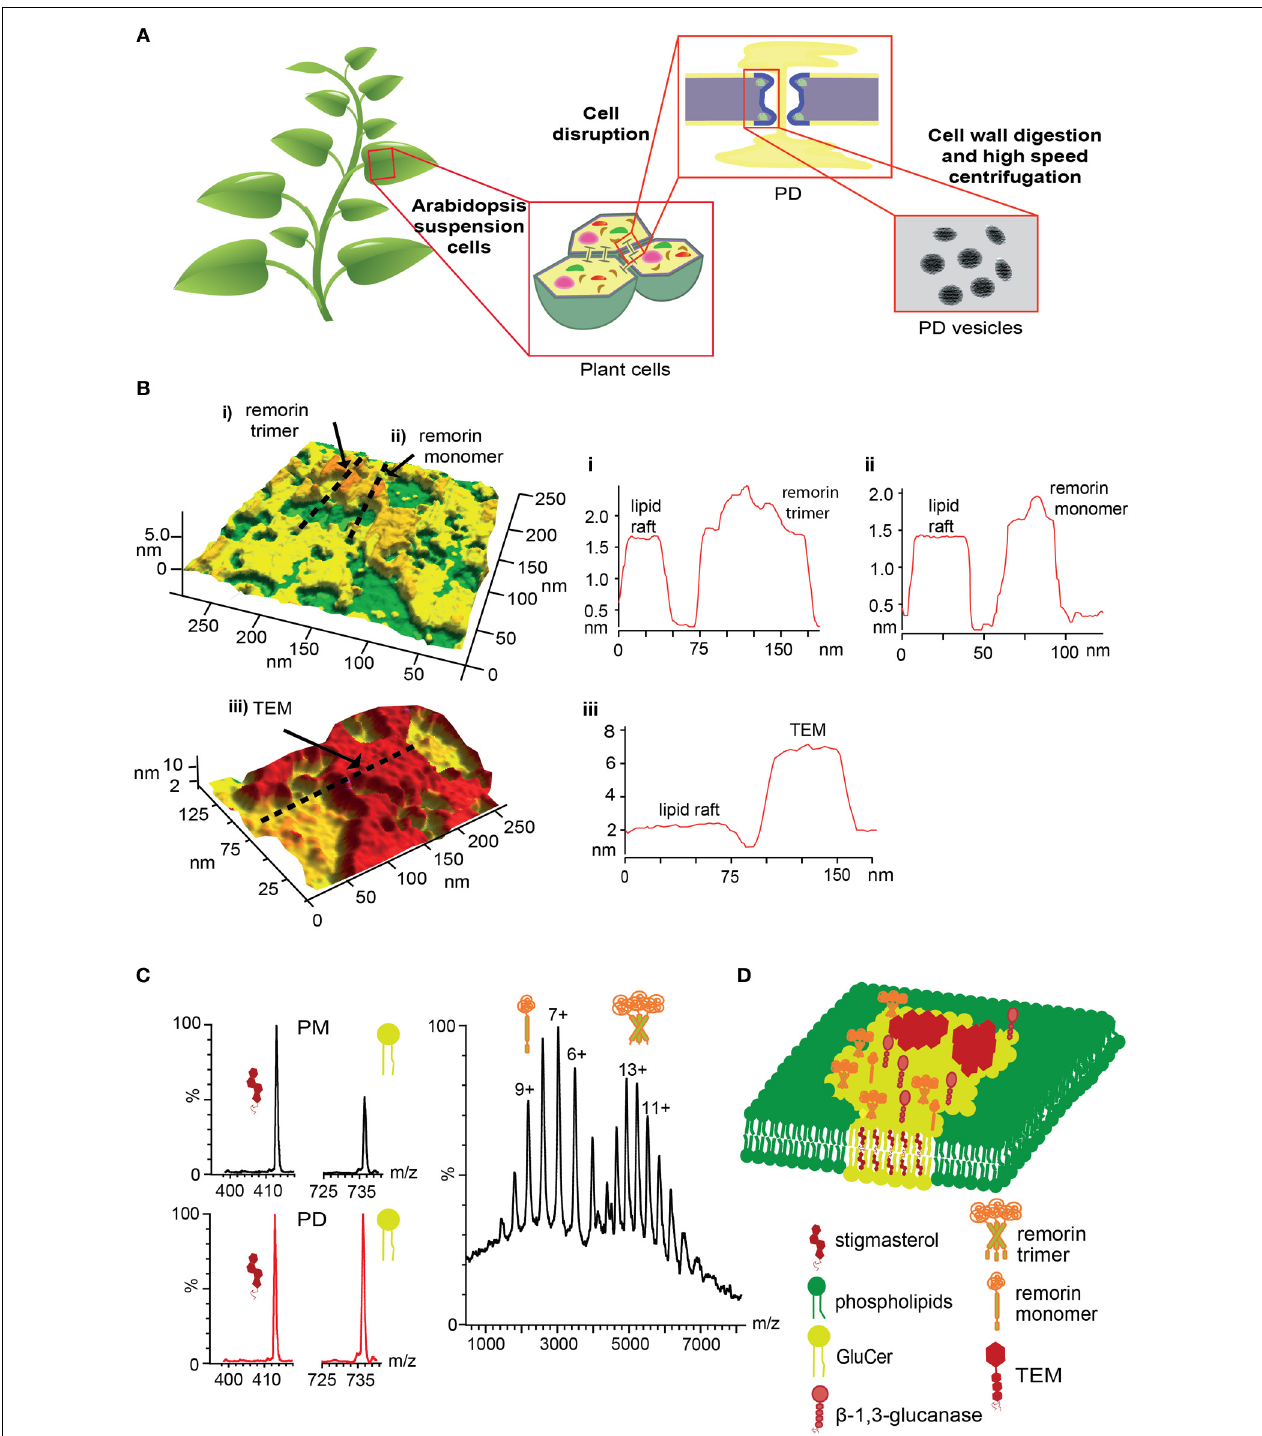
FIGURE 1 | Combined AFM and MS methodology to characterize the PD protein and lipid structure. (A) Scheme of the purification of PD vesicles from A. thaliana suspension cells. (B) AFM imaging simulations of lipid rafts, TEMs and remorin in PD membrane. Upper panel, AFM imaging of PM (green) and lipid rafts (yellow) where remorin (arrows) monomer and trimers can be localized above lipid raft domains. Lower panel, AFM imaging of lipid rafts and